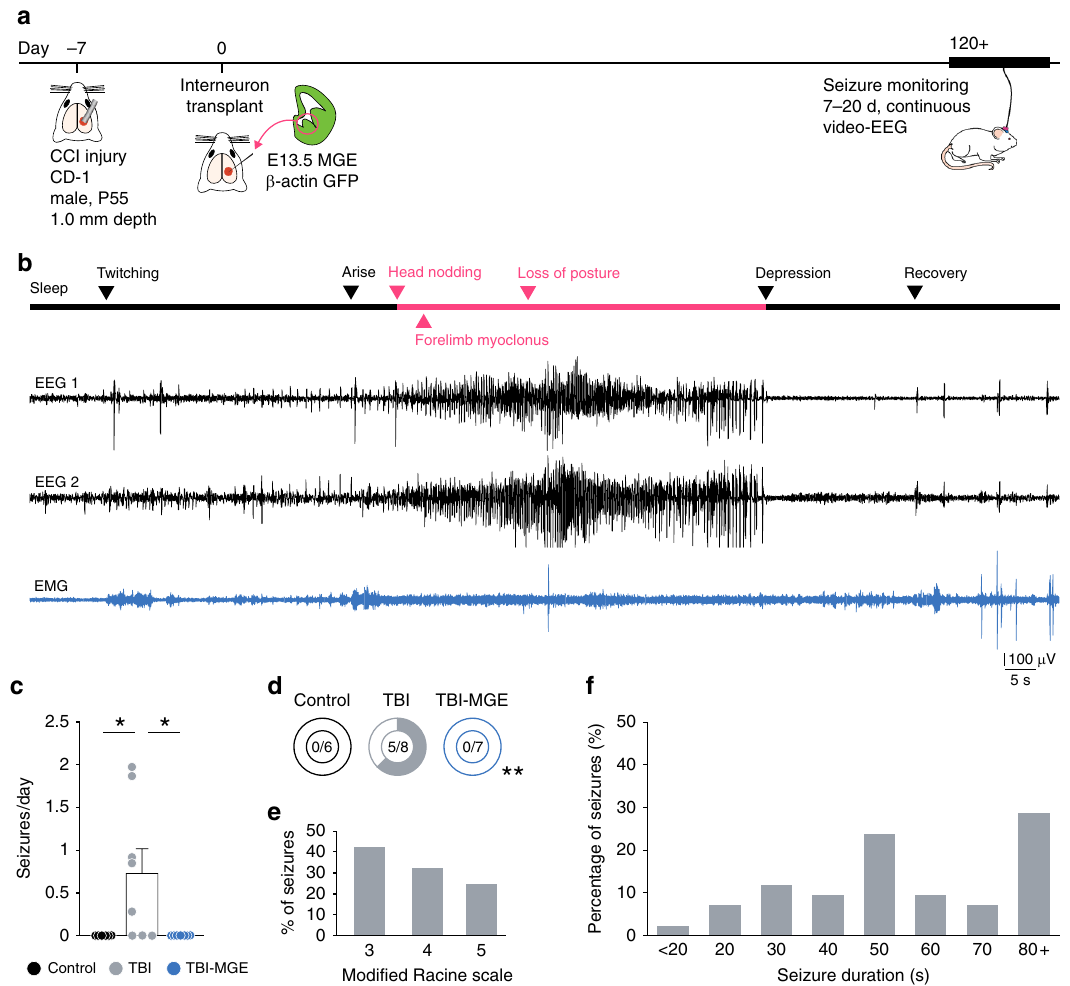
Fig. 7 Brain injured mice are seizure free after MGE transplantation. a Schematic showing the timeline for EEG experiments. b Example EEG recording (black) and corresponding EMG recording (blue) during a spontaneous seizure from a mouse 123 d after TBI. Arrows indicate behaviors observed at each phase of the recording. c Quanti fi cation of spontaneous seizure frequency (seizures per d) based on continuous EEG recordings (7 – 20 d). * P = 0.04, control vs TBI; * P = 0.03, TBI vs TBI-MGE; one-way ANOVA with Bonferroni post hoc test. n = 6 control mice, 8 TBI mice and 7 TBI-MGE mice. d Percentage of mice with spontaneous electrographic seizures. ** P = 0.004; Fisher exact test. e Distribution of seizure behavior based on a modi fi ed Racine rating scale. f Distribution of seizure duration in 10 s bins. See Supplementary Data 1 for statistical analyses. Error bars, s.e.m. Source data are provided as a Source Data fi